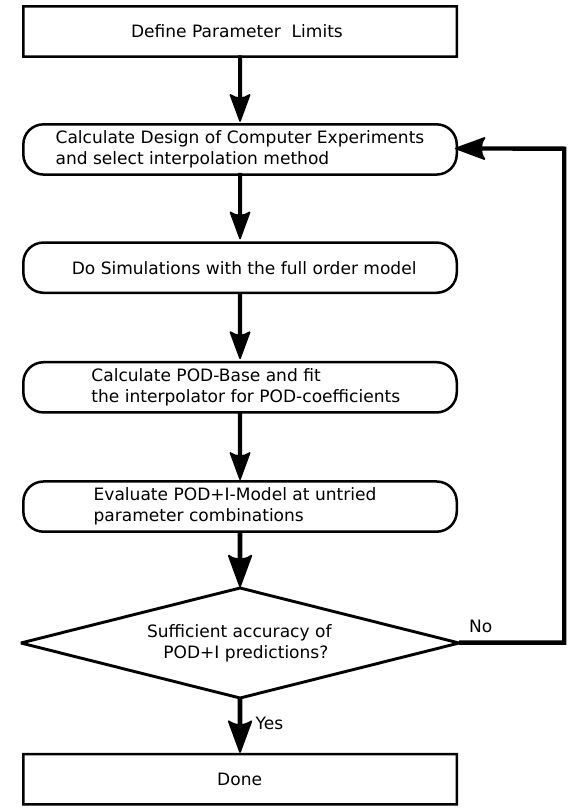
Figure 3. Flowchart of the used POD+I method. If insufficient prediction accuracy of the surrogate model is achieved, the design of computer experiments or the interpolation method is